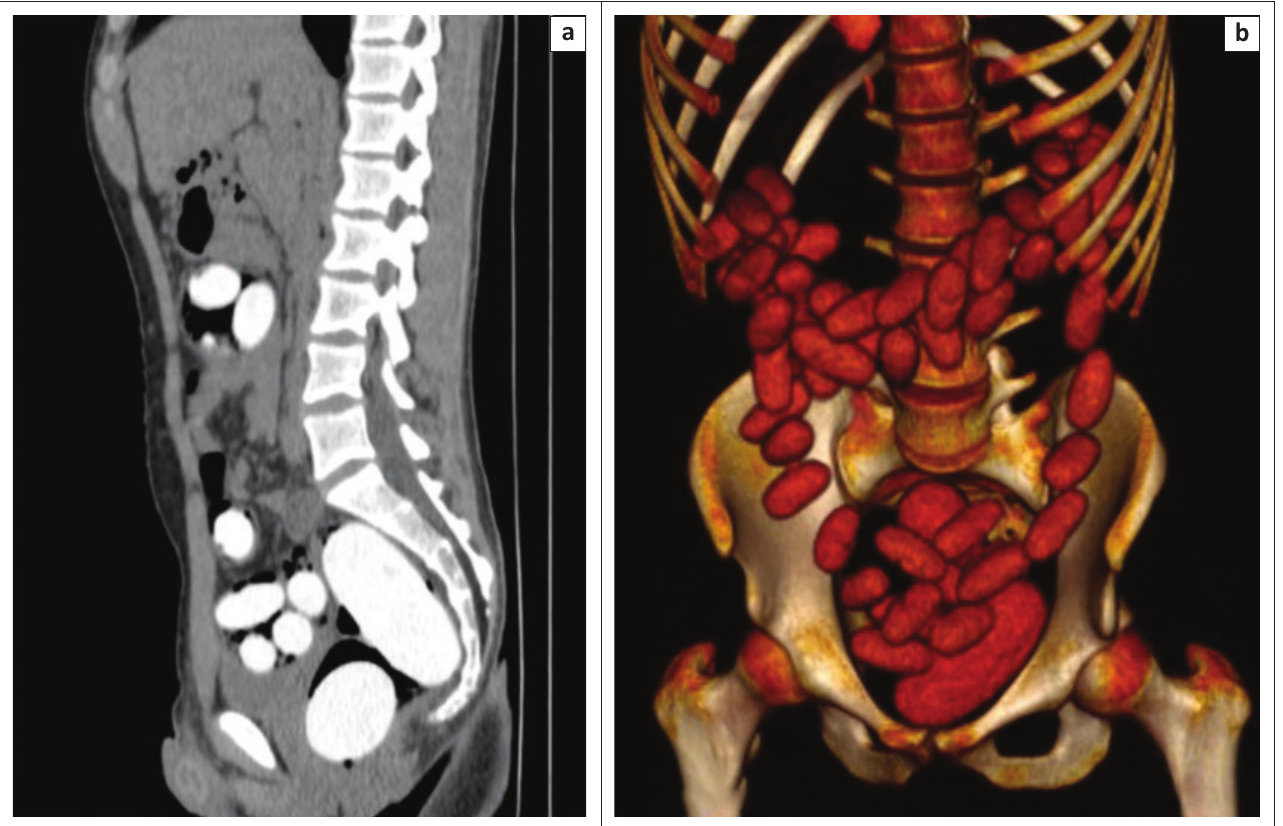
FIGURE 12: A 25-year-old male body packer and body pusher. (a) Sagittal computed tomography imaging of the intestinal loop lumens without contrast material revealed multiple hyperdense drug-filled capsules along with two bigger sized packages in the lumen of the rectum. (b) Three-dimensional volume-rendering technique images distinguish the capsules more easily. A total amount of 1093 g of 60 cocaine capsules were obtained from this